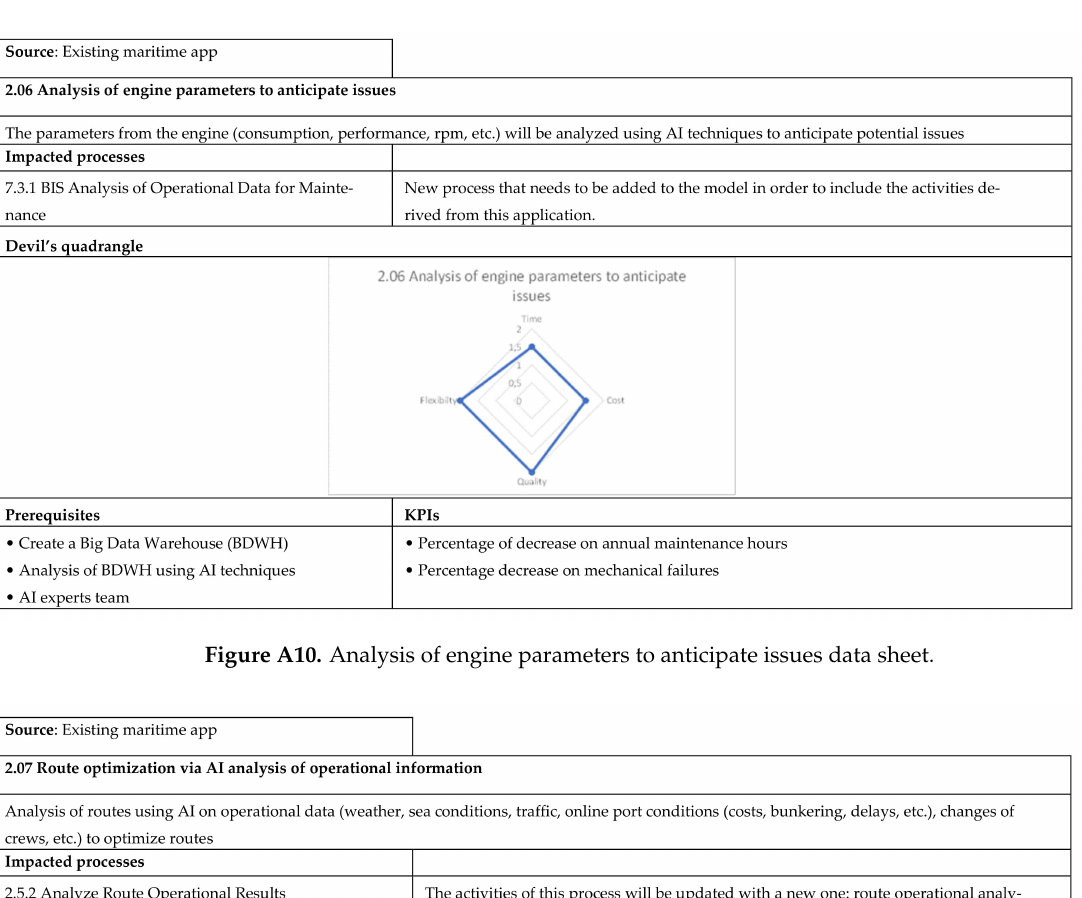
Figure A9. Client offering optimization via AI analysis of client information data sheet.